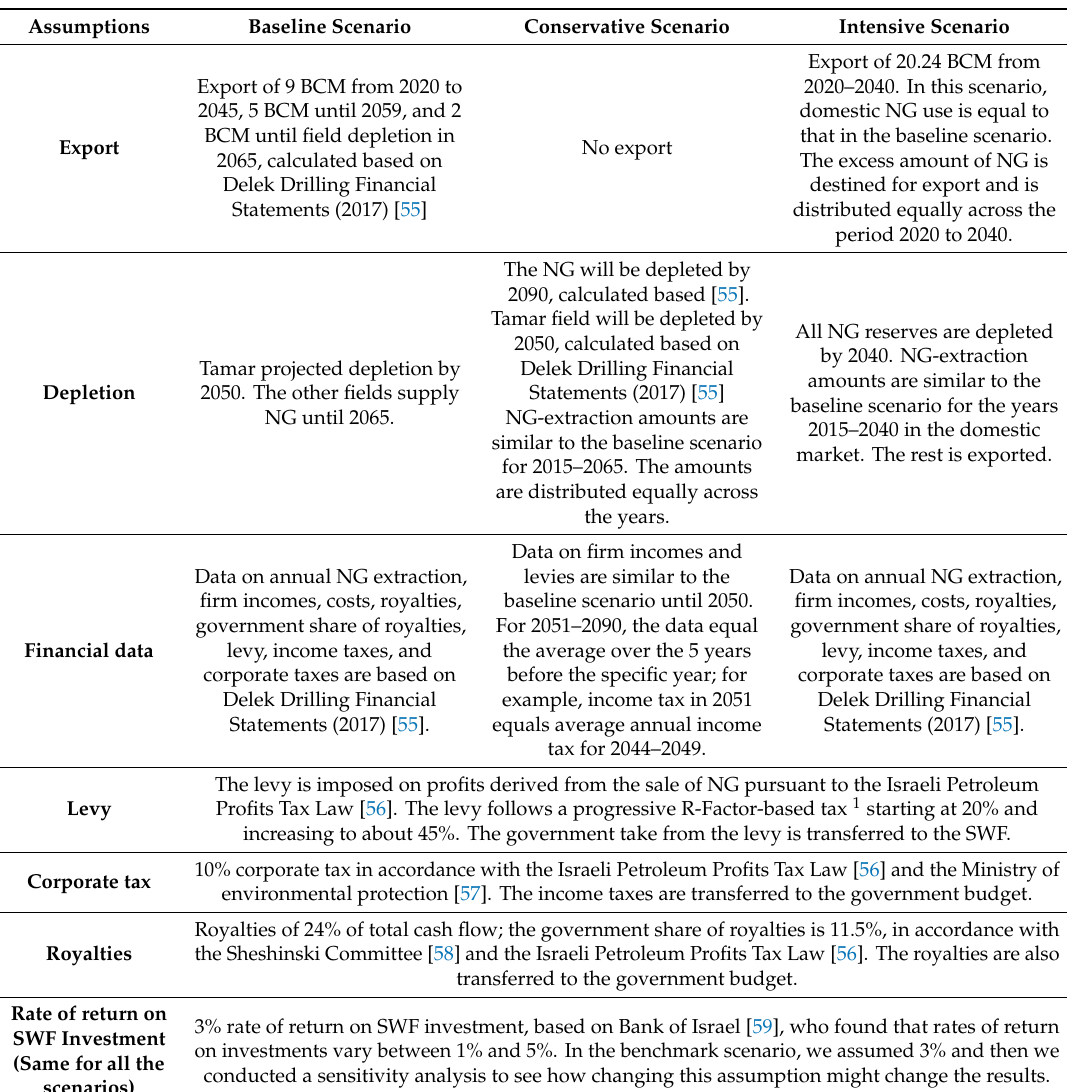
Table 2. Data assumptions and sources across the three